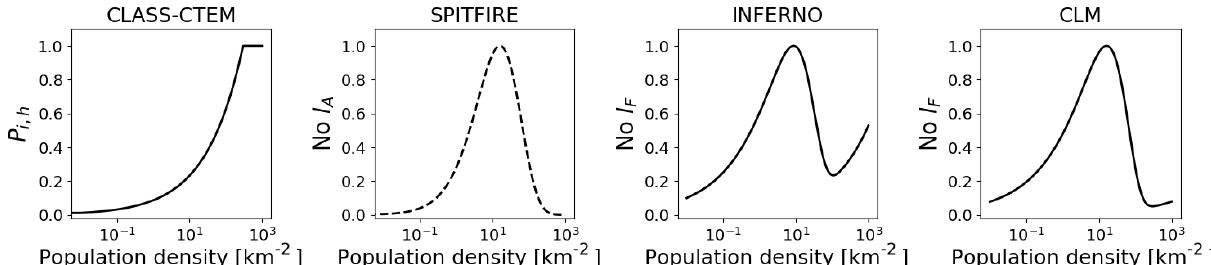
Figure 7. Variation in probability of fire due to human ignitions ( P i , h ), anthropogenic ignitions (No I A ) or number of fires (No I F ) for changes in population density. Since all models use different units, the values are scaled to the value range (0,1).